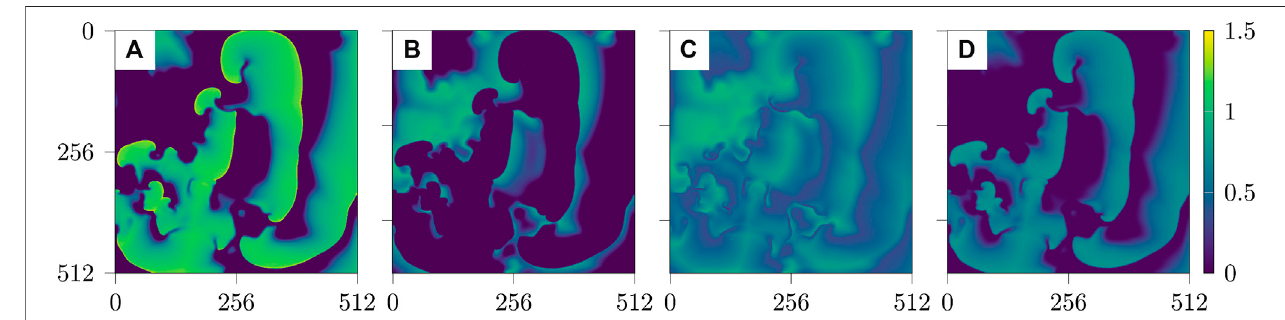
FIGURE 1 | Snapshots of the four fi elds u, v, w, s of the BOCF model Eq. (1) (from left to right).